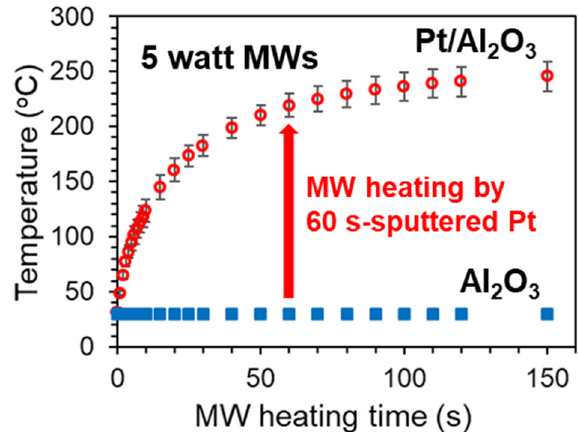
Figure 2. MW heating of 60 s-sputtered and 300 ◦ C-calcined Pt / Al 2 O 3 substrate and 600 ◦ C-calcined bare Al 2 O 3 substrate. The substrates were put at the maximum point of electric field. Each heating experiments were repeated by 4 times to depict the error bars.